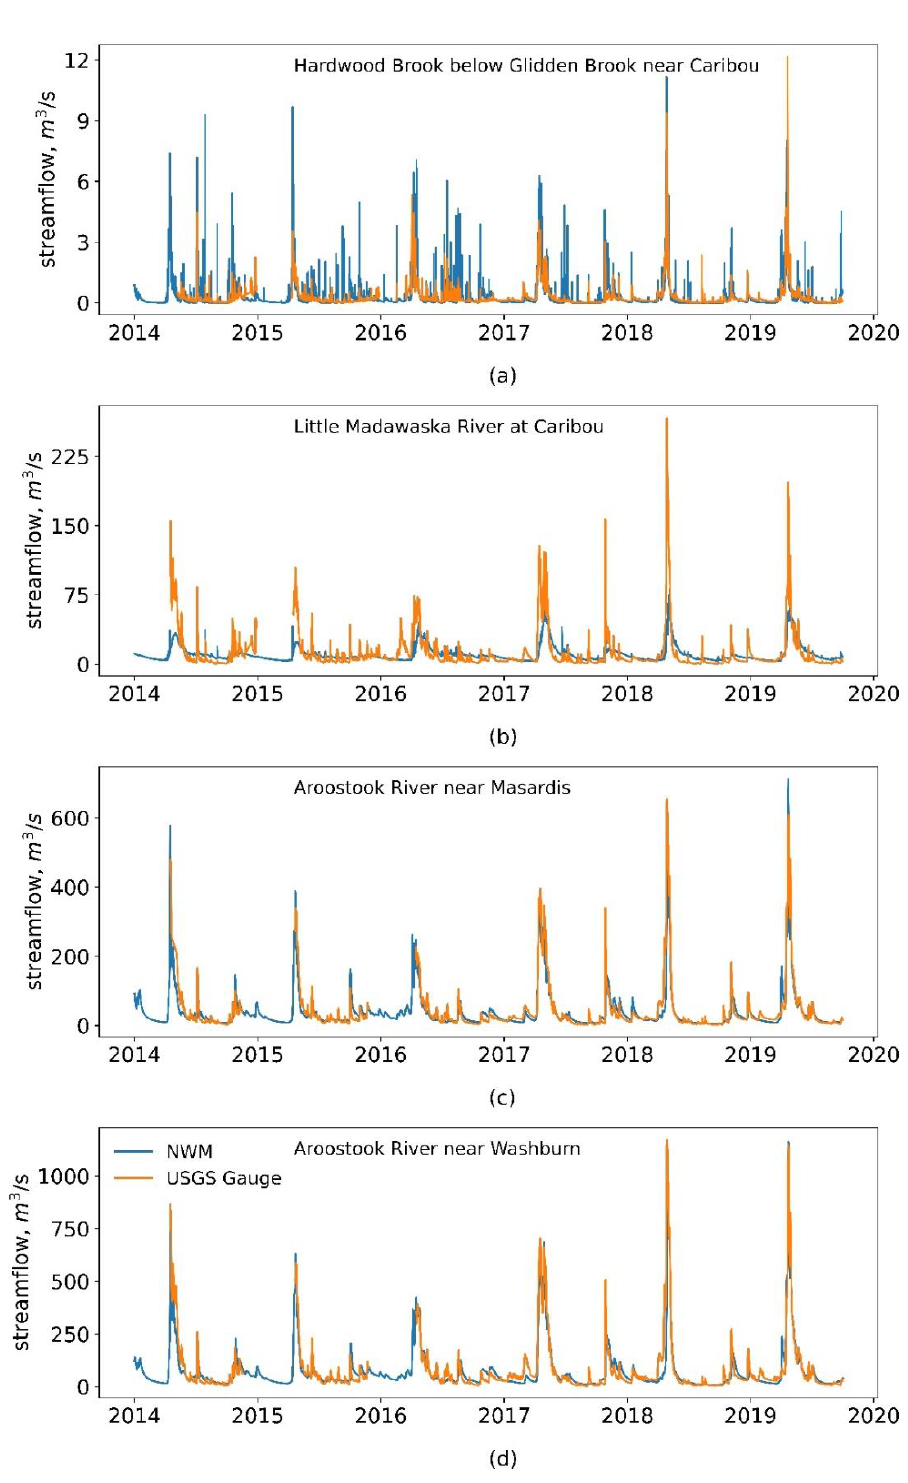
Figure 9. Comparison of the runoff from NWM V2.0 and the streamflow from USGS gages at ( a ) Harwood Brook; ( b ) Madawaska; ( c ) Masardis; ( d ) Washburn stations from WY2014-WY2019. Table 5. NSE, PBIAS, RSR, and KGE for simulated runoff compared with the observed streamflow at the four USGS gage locations: Hardwood Brook, Madawaska, Masardis, and Washburn stations.